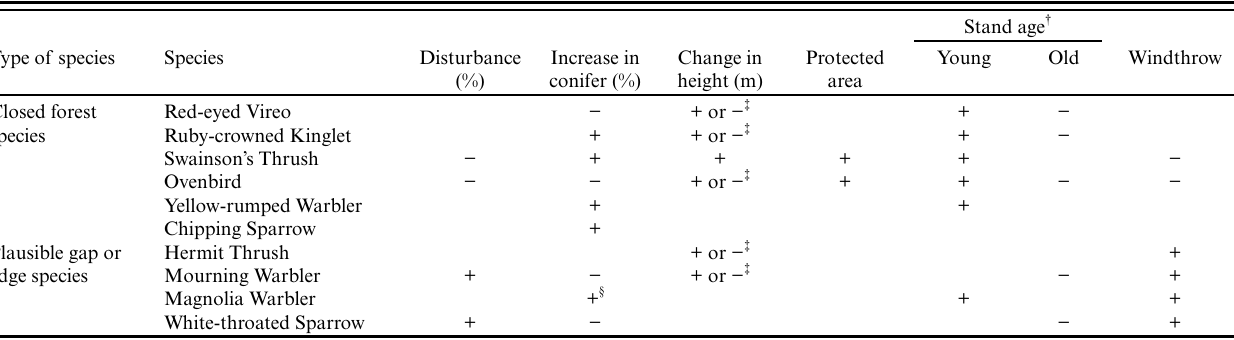
Table 1. Hypothesized influence of covariates on local trends in abundance for 10 bird species in the aspen-dominated boreal mixedwood forests of central Saskatchewan.